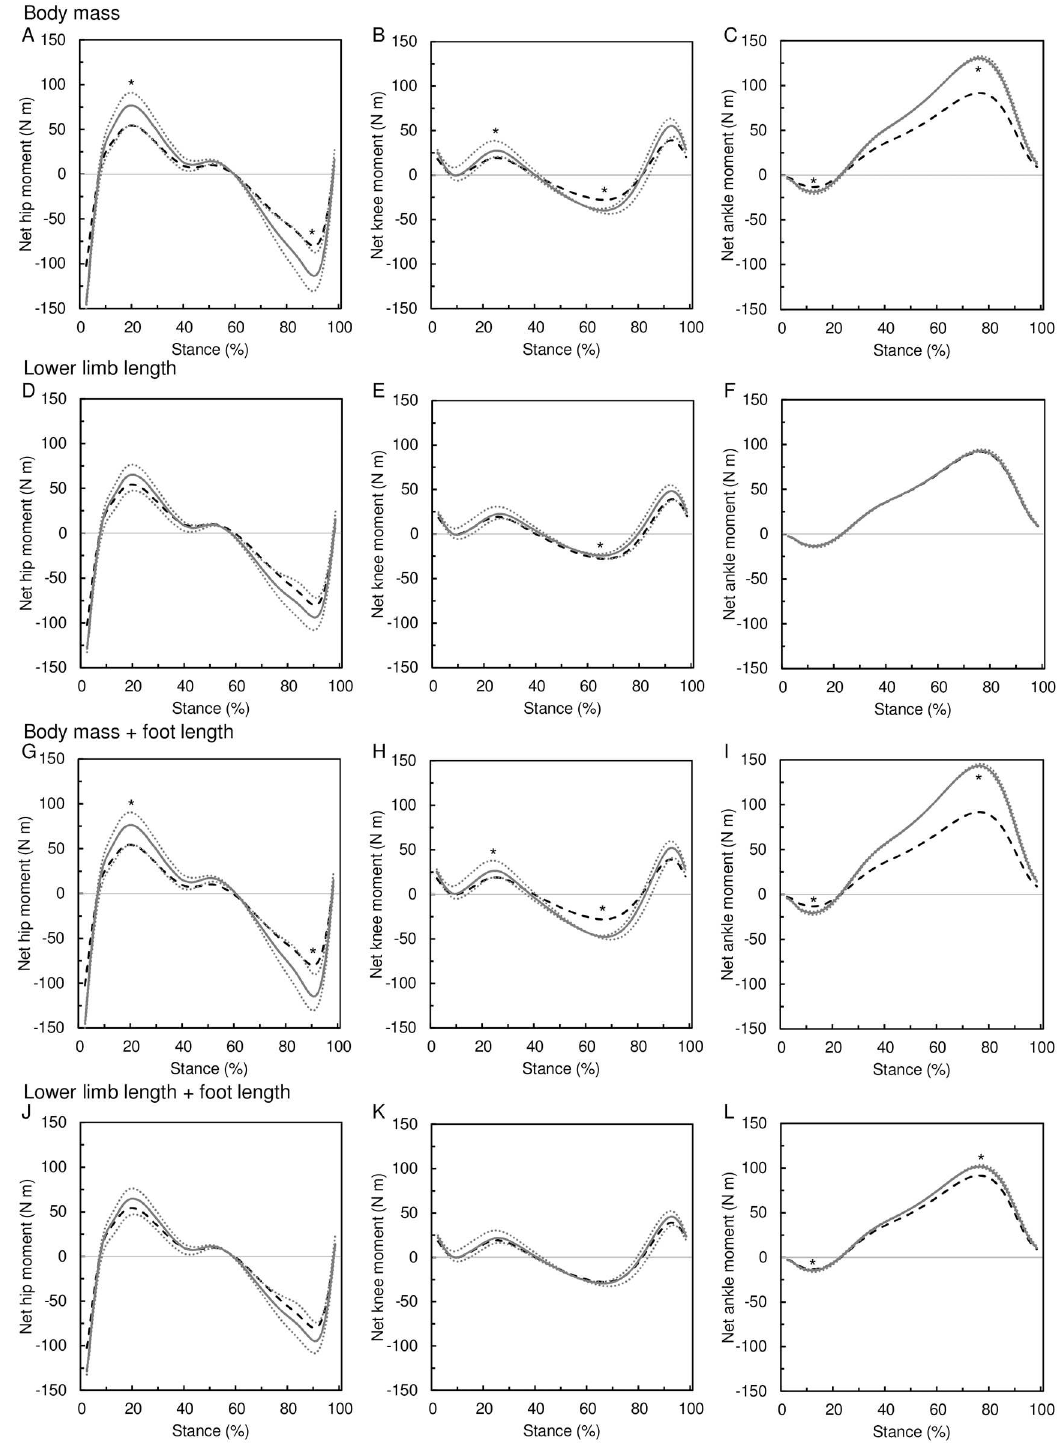
Fig 6. Effect of body size on net joint moments. The effect of body mass increase(A–C) and lower limb length increase (D–F) on net joint moments at the hip (A, D), knee (B, E), and ankle (C, F). Manipulatedsize (gray solid line) is compared to the originalsize (black dashed line). The gray dotted lines represent the moments after the size manipulation estimated using the mean ± 2 SDs divergent point location.The asterisk indicatesthe peak joint moment of the manipulatedbody size is different from the originalmoment regardlessof the divergent point